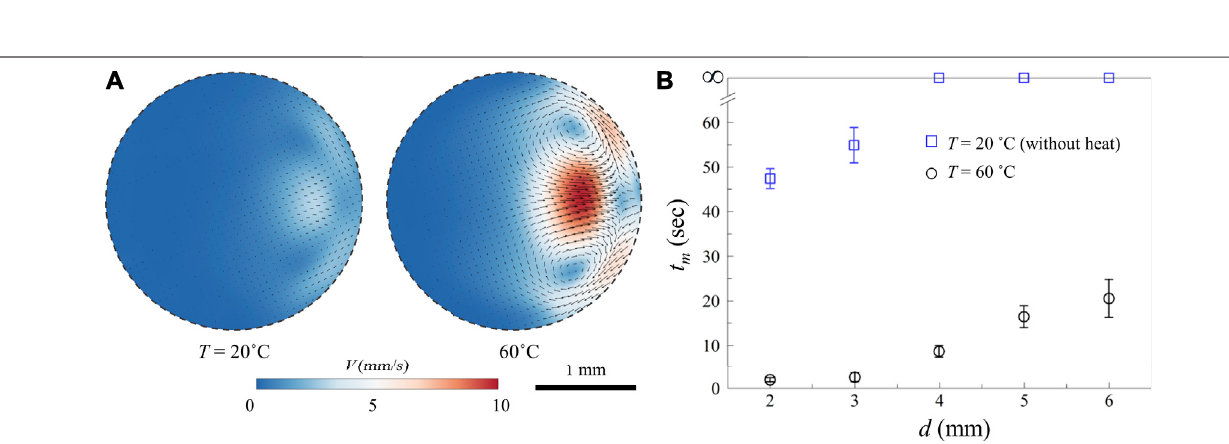
FIGURE 7 | (A) PIV results for the acetone vapor-mediated solutal Marangoni fl ow fi elds formed in the water/glycerol mixture solution droplet with viscosity of 3.7 mPasat T (cid:2) 20 ° C (left) and60 ° C (right) . (B) Thetimerequiredforcompletedigitalmicro fl uidicmixing( t m )asafunctionofthedynamicviscosityofthesessiledroplet at T (cid:2) 20 ° C (blue) and 60 ° C (black).